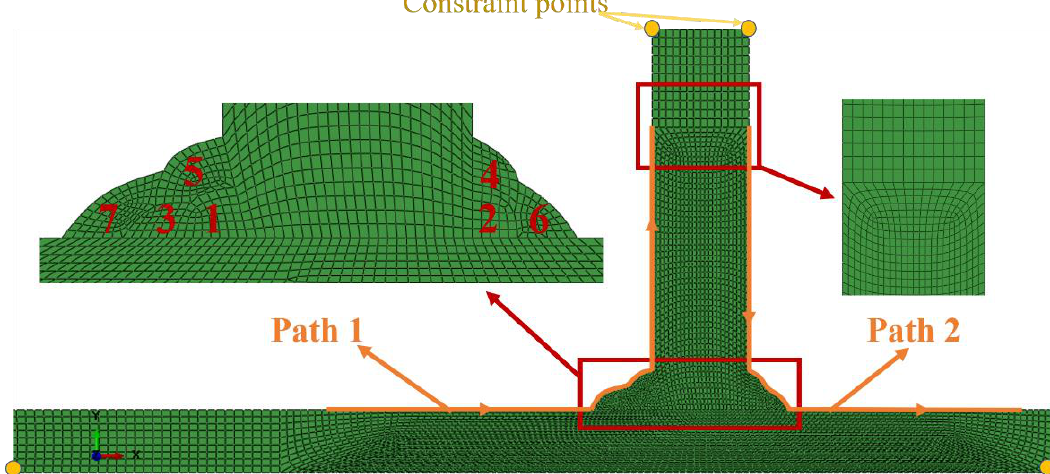
Figure 5. Finite element model.